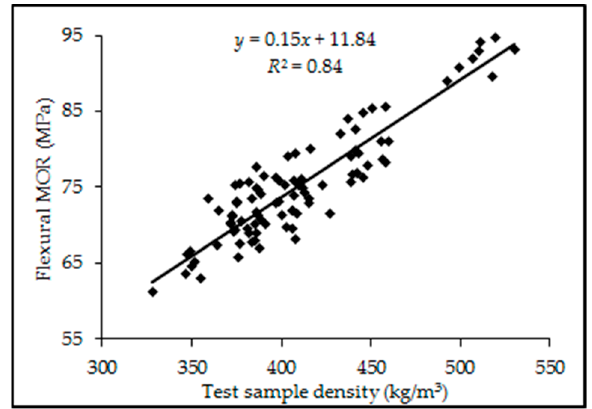
Figure 4. Relationship between test sample density and flexural modulus of rupture.